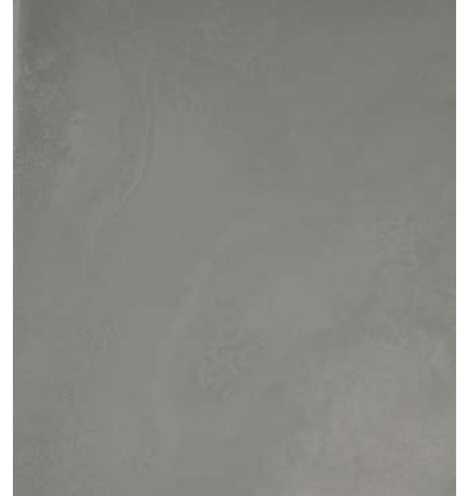
Fig. 15 Sample with the film 3 and paint sprayed on the glass before the aging process